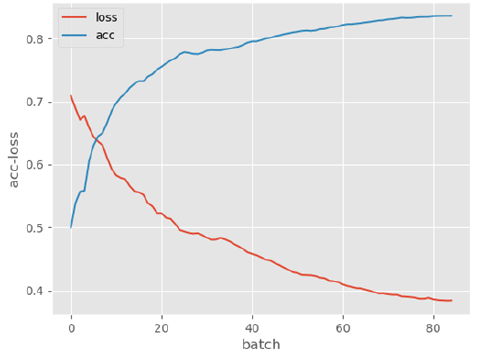
Figure 6. Acc – Loss chart.